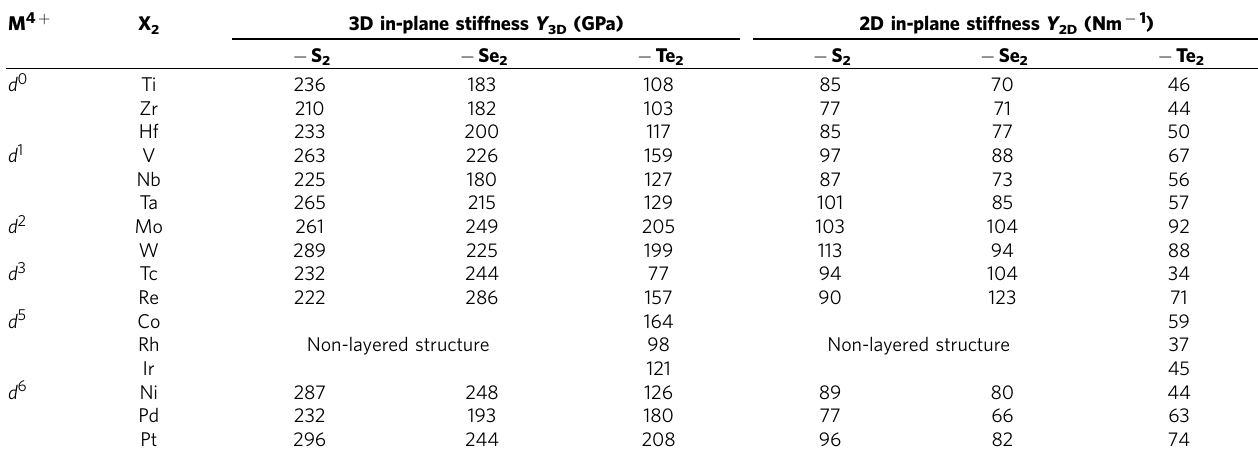
The3D in-plane stiffness(Young’s Modulus)( Y 3D )is calculated from2D in-planestiffness ( Y 2D )divided by the effectivelayerthickness t givenby t ¼ t o þ 0.8Å, where t o is the distance betweenthe top and bottom chalcogen atom